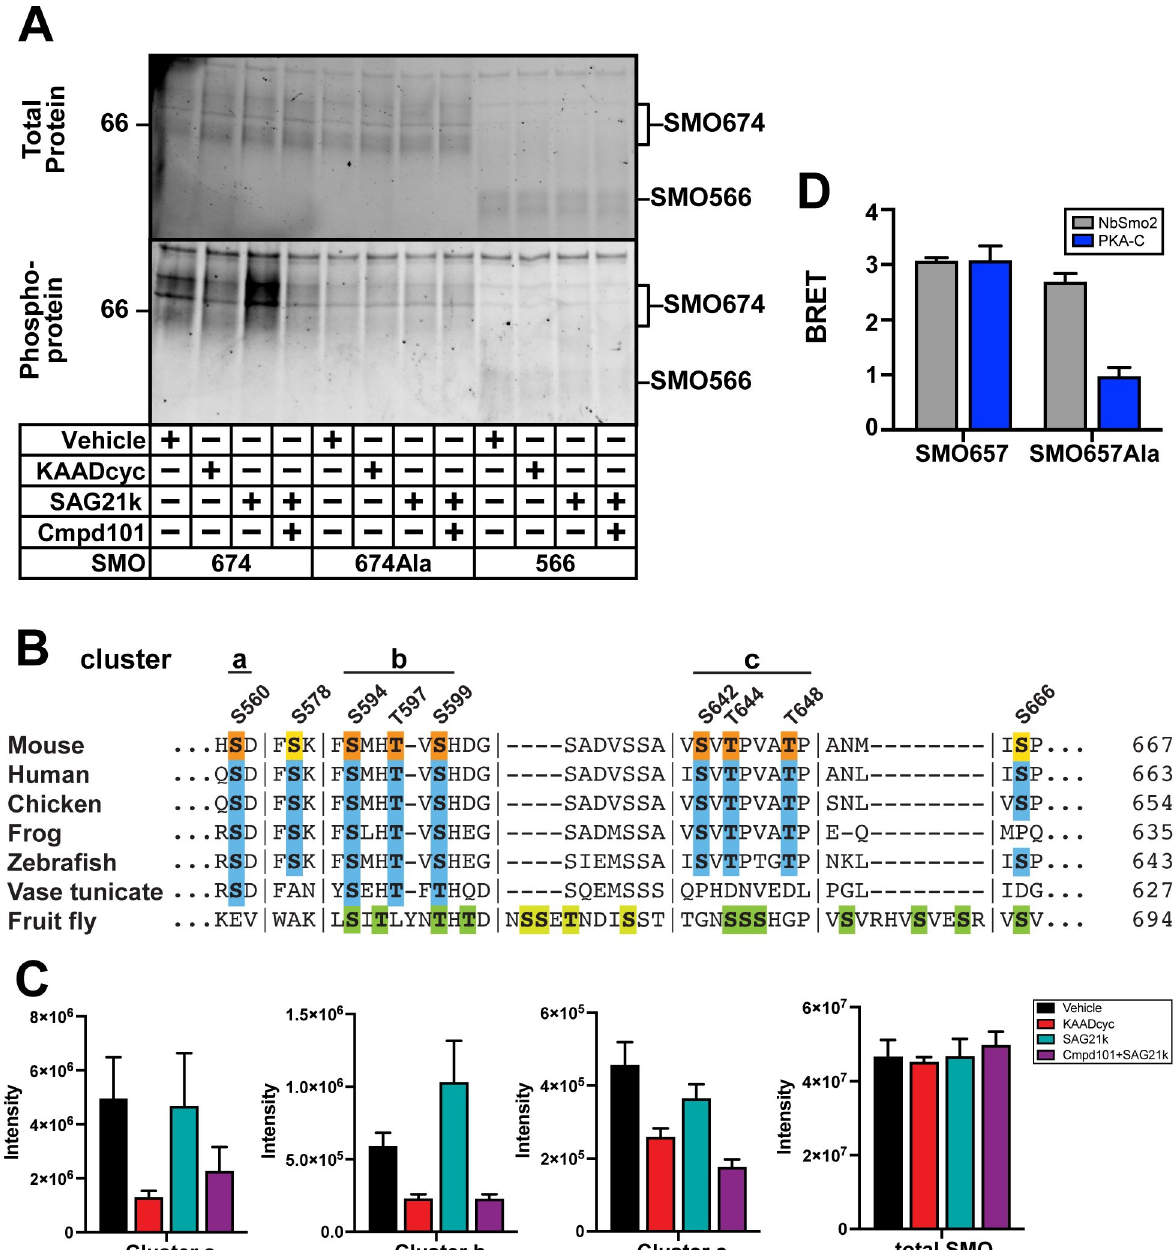
Fig 6. GRK2/3 phosphorylation of conserved SMO pCT residues mediates PKA-C binding. ( A ) HEK293 cells expressing GRK2 and either SMO674 (lanes 1–4), SMO674Ala, which carries mutations in 7 GRK2/3 phosphorylation sites (lanes 5–8), or SMO566 (lanes 9–12). Following treatment with SMO modulators or Cmpd101 (4 hours), SMO was isolated via FLAG affinity chromatography, and total protein or phosphoprotein was visualized using Stain-Free imaging or Pro-Q Diamond staining, respectively. Although GRKs often phosphorylate GPCRs on the intracellular loops of their 7TM domains [67,68],we did not observe phosphorylation within this region of SMO via phosphoprotein staining (A) or MS ( S10 Fig ). Molecular masses are in kDa. ( B ) Clusters of phosphorylated residues identified by MS are labeled above the sequence of mouse SMO. Orange indicates phosphorylation that depends on SMO and GRK2/3 activity, while yellow indicates non-GRK phosphorylation sites. Alignment with SMO from other species reveals sequence conservation (blue), particularly among vertebrates. Green indicates GRK phosphorylation sites previously mapped in Drosophila Smo [80]. Vertical lines indicate breaks in sequence. See S9A Fig for complete alignment. ( C ) Targeted MS-based quantification of phosphorylation at each of the 3 activity- and GRK2/3-dependent clusters in the SMO pCT (left 3 graphs) and total SMO protein in each sample (right-most graph). “Intensity” is a measurement of the abundance of phosphorylation sites (left) or total protein (right), derived from model-based estimation in MSstats which combines individual peptide intensities (see “Methods”). ( D ) BRET between PKA-C and wild-type SMO657 or SMO657Ala. Data in (C): n = 3 biological and 3 technical replicates per condition. Data in (D): n = 3–6 biological replicates per